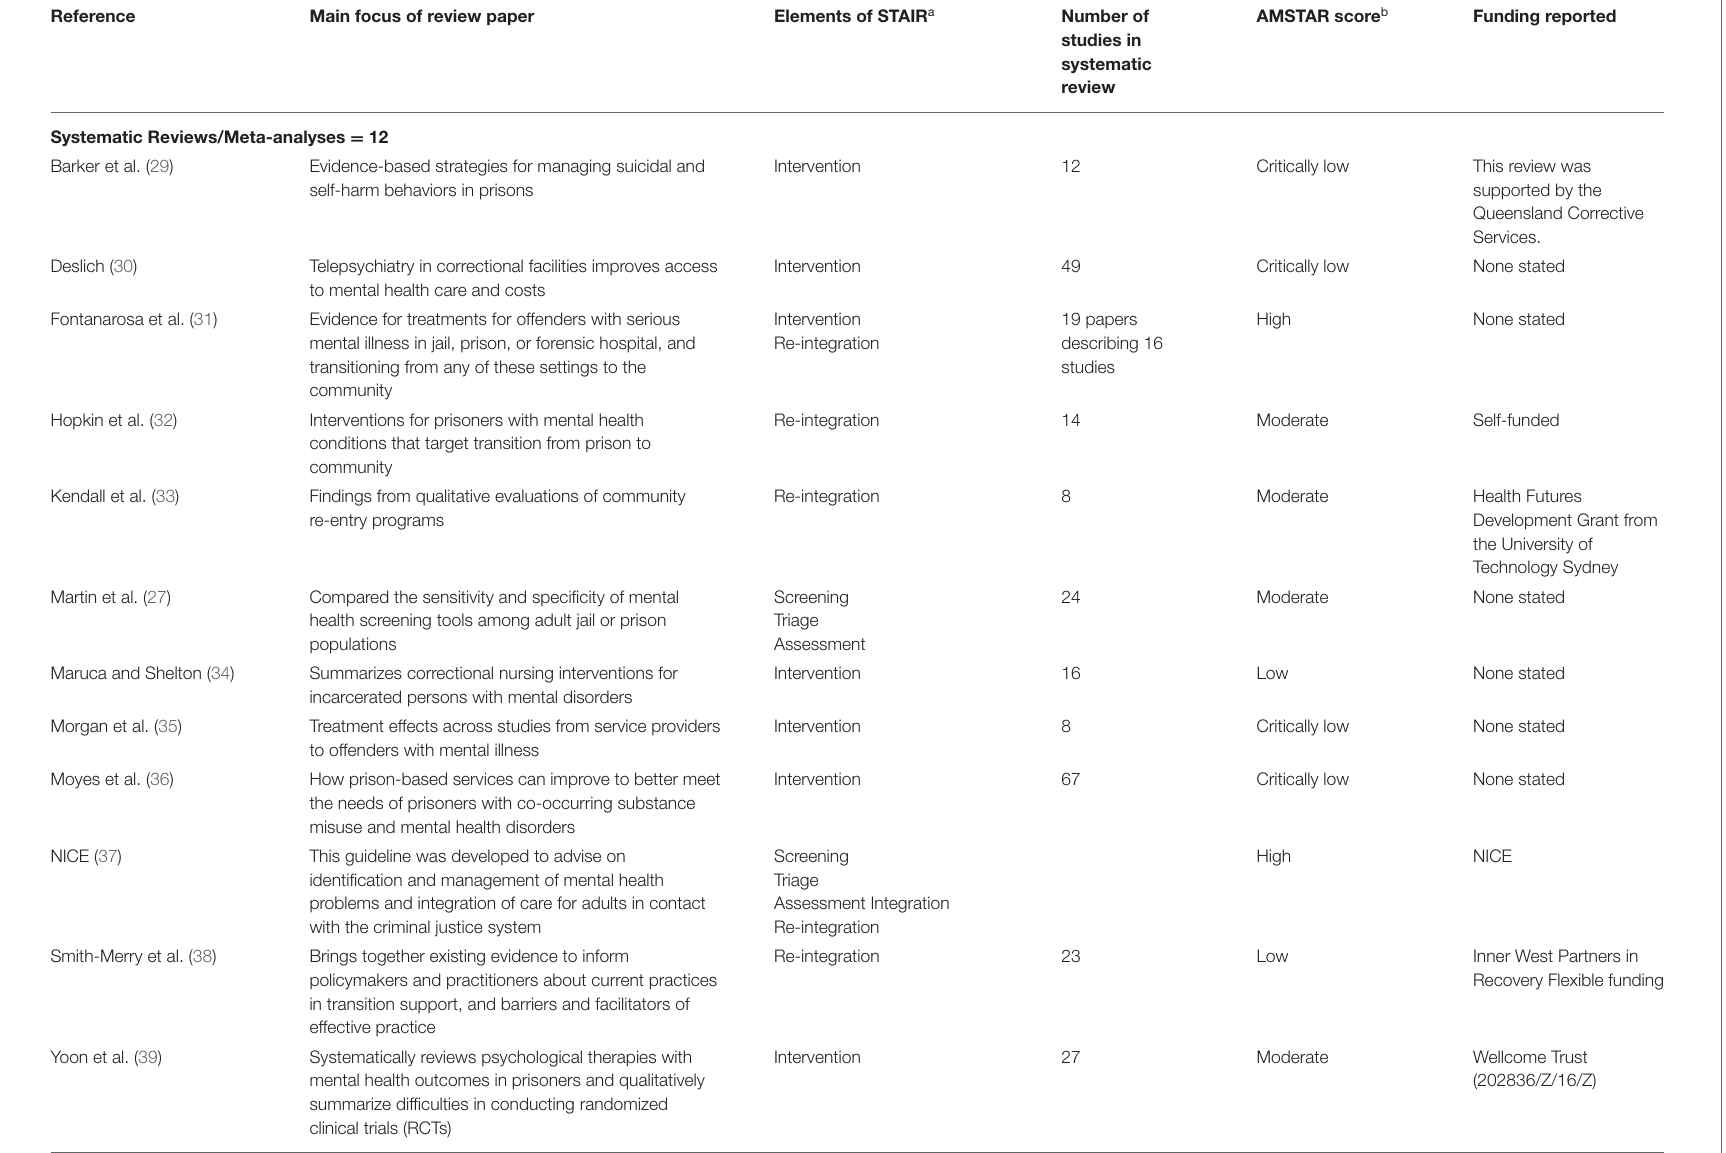
TABLE 1 | Data extraction table of included